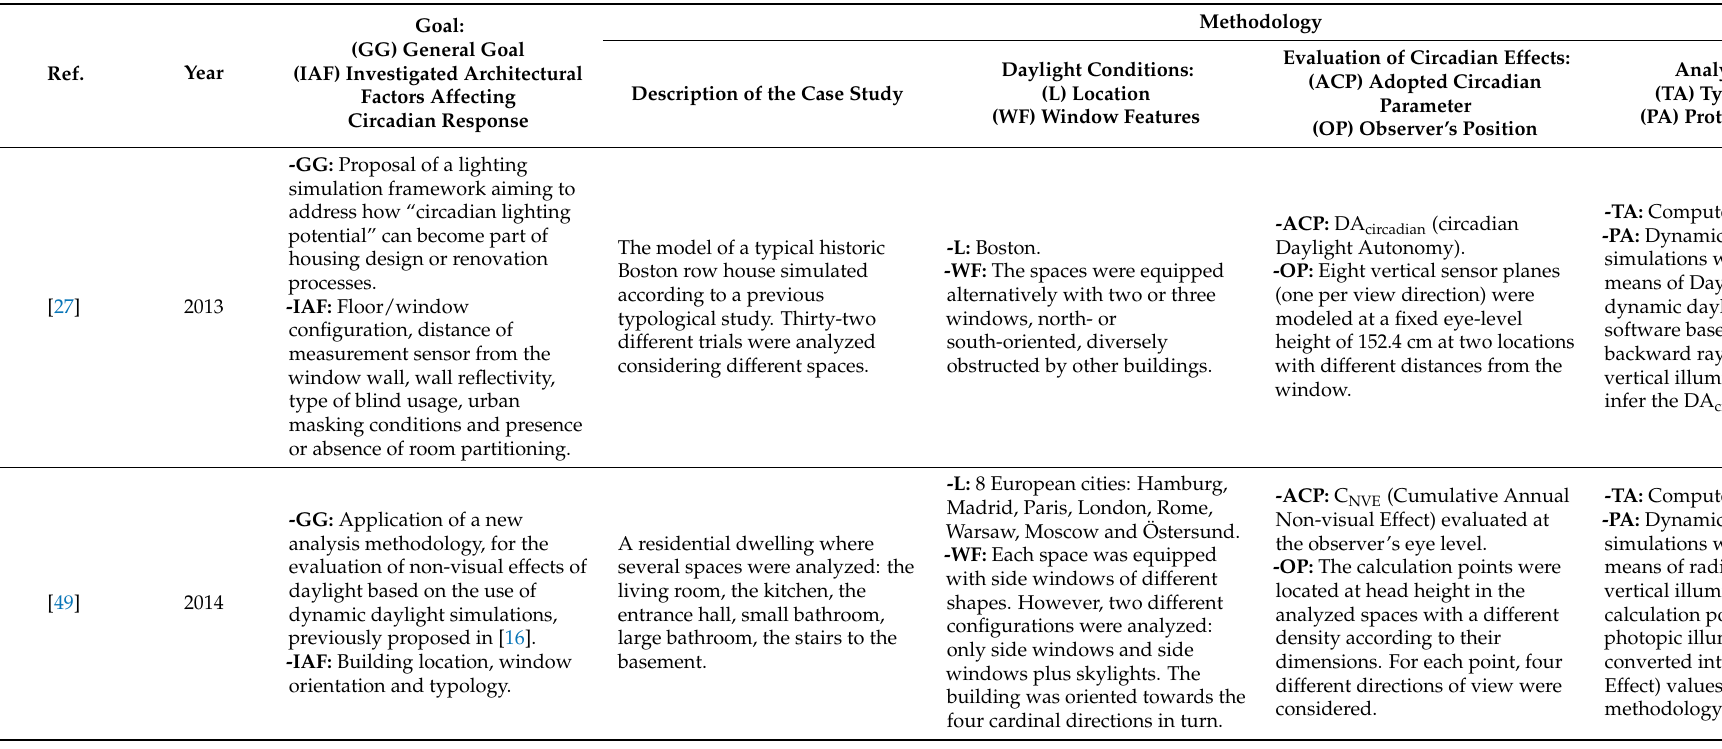
Table 1. Papers analyzing factors related to urban and architectural